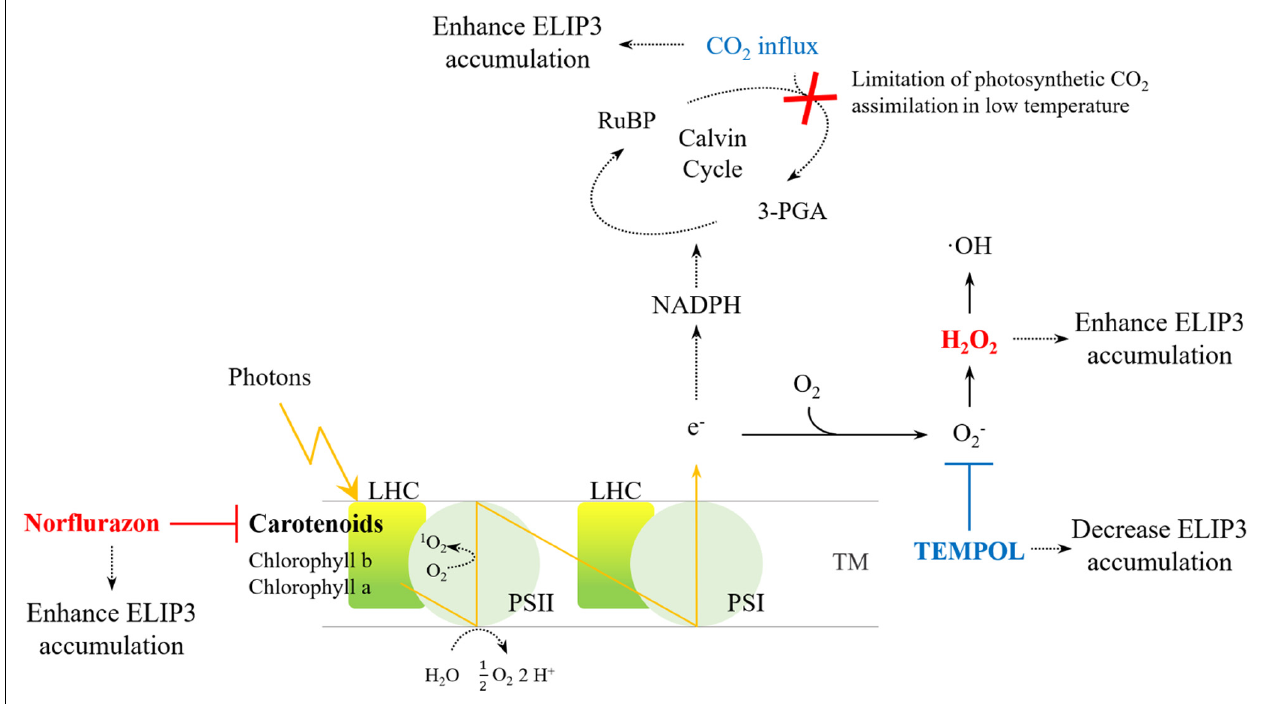
FIGURE 10 | An overview of ROS generation in PSI and PSII and the effect of redox agents. The activity of the CO 2 fixation enzyme, in the Cavin cycle, is limited under low temperatures, thereby leading to ROS production due to over-reduction of the photosystems. Increased CO 2 may dissipate excess energy in the photosystems. The redox reagents were used to increase ROS (red) or to scavenge ROS (blue) in each photosystem. LHC, Light-harvesting complex; PS, photosystem; RuBP, Ribulose 1,5-bisphosphate; TM, thylakoid membrane; 3-PGA, 3-phosphoglyceric